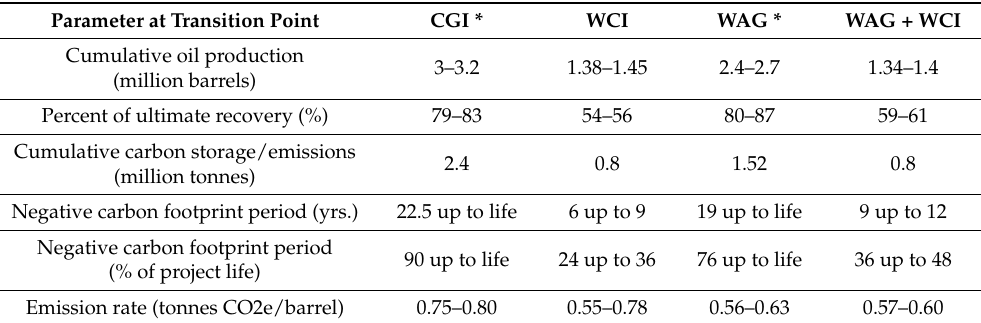
Table 4. Important CCUS parameters at the transition point (CO 2 storage = CO 2 e emissions). Scenarios with stacked saline carbon